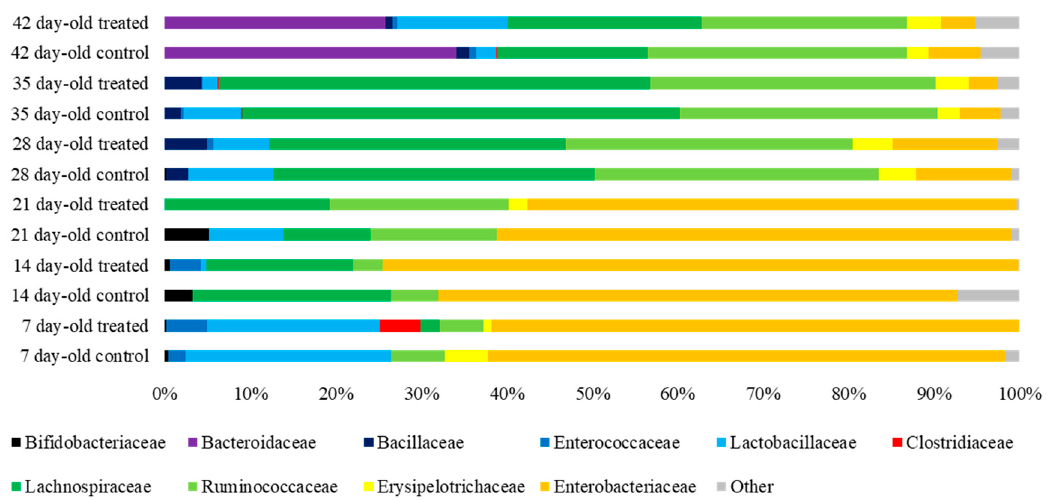
Figure 5. Bar chart showing the 10 most abundant bacterial families found in the cecal content of control and treated broiler chickens challenged with Salmonella Typhimurium at 7 days of life. Each bar represents the relative abundance (horizontal axis) of bacterial families by group of animals, diet treatment, and age.